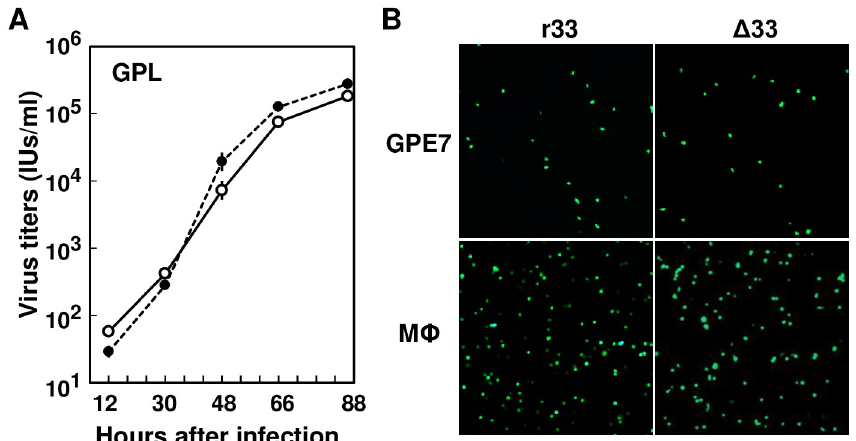
Fig 3. Viral infection in vitro . (A) GPL cells in 48-well plates were infected with GPCMV r33 and Δ 33 at an MOI of 0.05, and culture supernatants were recovered and frozen at the indicated hours after infection. The viral titers (IUs) were determined by counting GFP-positive cell foci at 2 days after infection. Means and SEMs of the virus stocks prepared in triplicated wells are plotted for r33 (open circles) and Δ 33 (closed circles). (B) Representative images of GFP-positive cells after infection of GPE-7 cells and macrophages (M ϕ ) with r33 or Δ 33 at an MOI of 10 (the virus titers were determined in GPL cells) at 24 hrs and 36 hrs p.i., respectively.